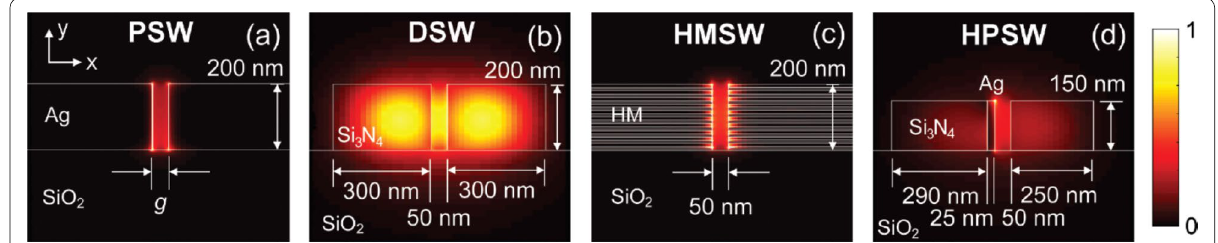
Fig. 4 The x–y cross section and EM energy density distribution w (ρ) [ J / m 3 ] of a Ag plasmonic slot WG (PSW) with gap width g, b Si 3 N 4 dielectric